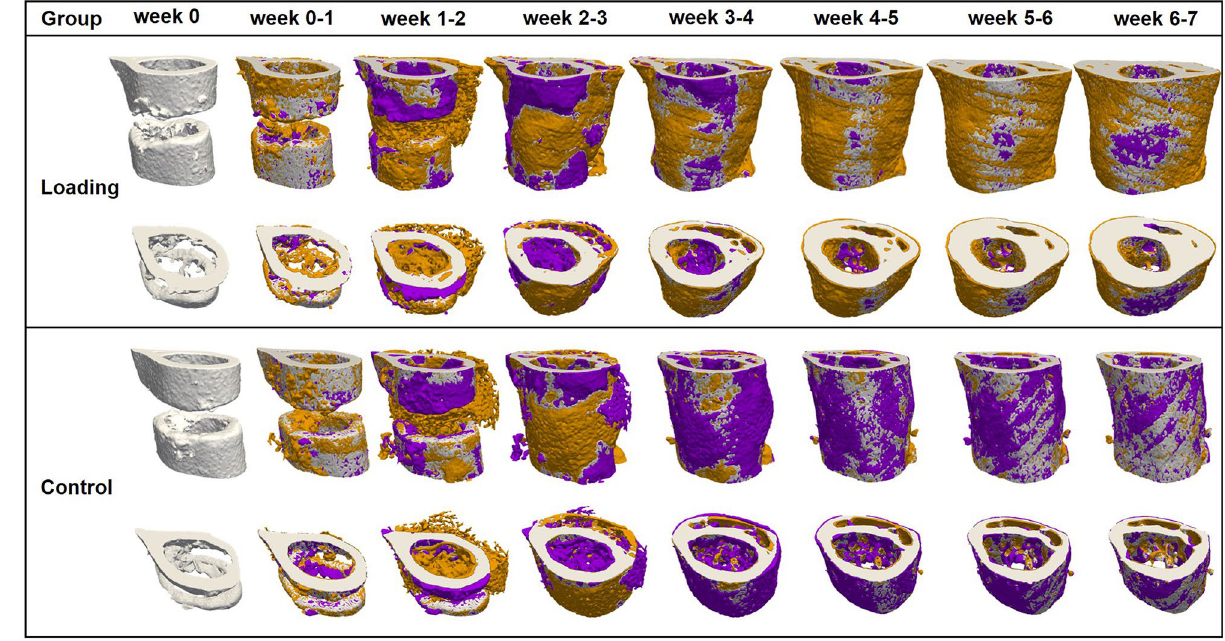
Figure 2. Longitudinal imaging of the defect region via micro-CT. Representative images (full image and cut; threshold: 645 mg HA/cm 3 ) of the defect region from animals of the loading group (week 0–7) and the control group (week 0–7). Visualization of bone formation (orange) and resorption (blue) via registration of micro-CT scans from weeks 1–6 to weeks